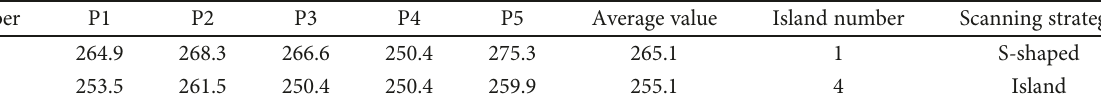
Table 3: Microhardness measures for samples (HV).